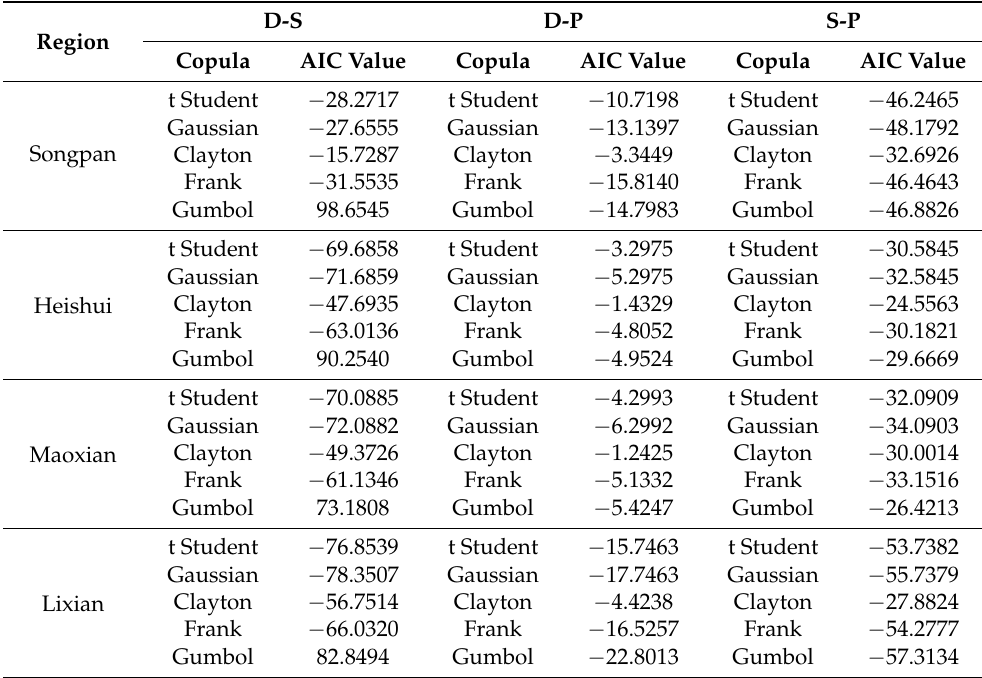
Table 6. AIC evaluation value of each copula function.